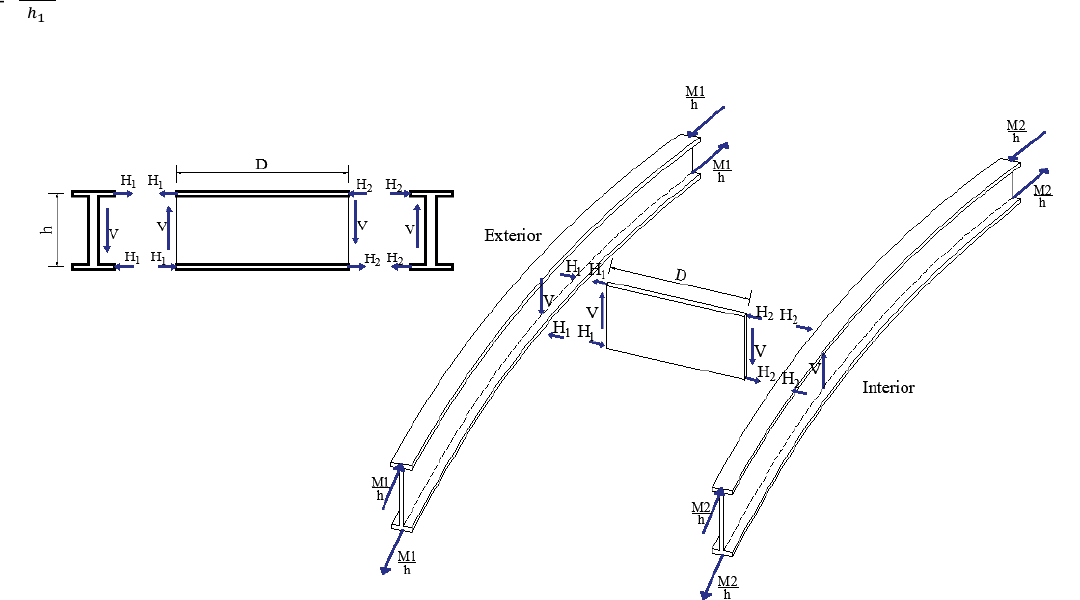
Figure 3. View of the bridge focusing on the diaphragms. Adapted from Fiechtl et al.